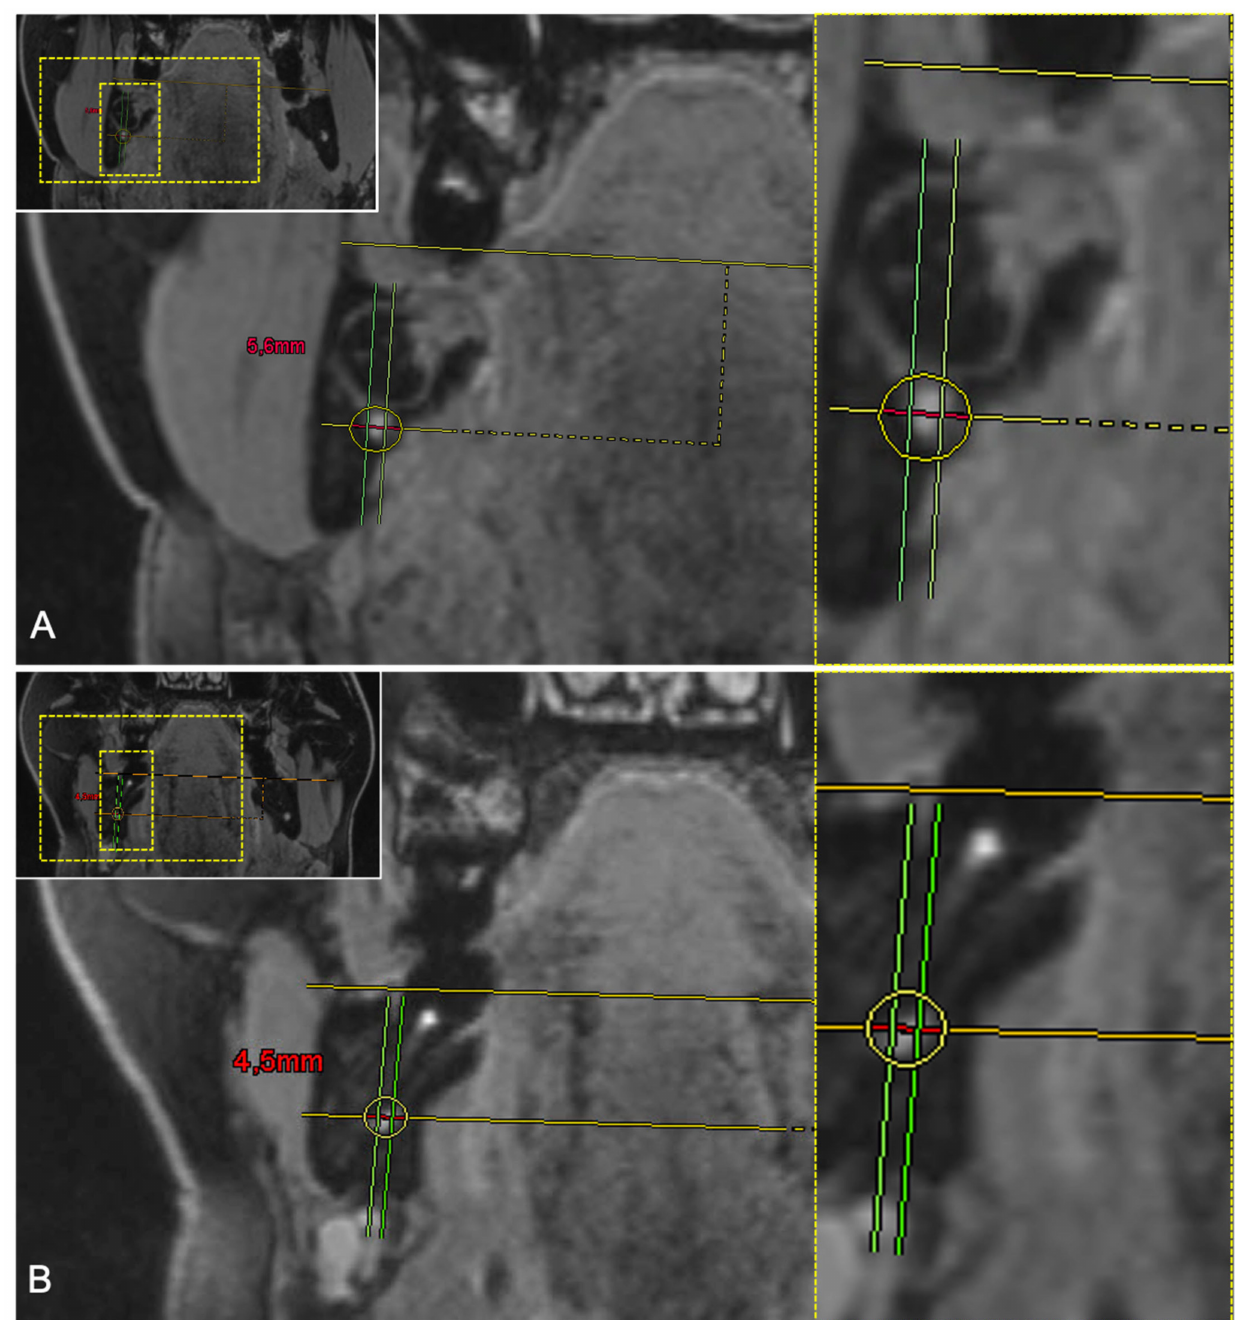
Figure 3. ( A ) Coronal reconstruction of a study participant’s 3D-DESS MRI images visualizing the intraosseous IAN evaluation at the third molar. For orientation, the dotted rectangles in the corner show the enlarged area. The upper middle segment (segment 2) and the lower middle segment (segment 5) are occupied by MRI signal hyperintensities. ( B ) Coronal reconstruction of a study participant’s 3D-DESS MRI images visualizing the intraosseous IAN evaluation at the level of the second molar. The upper lingual segment (segment 3), lower buccal segment (segment 4), and the lower middle segment (segment 5) are occupied by MRI signal